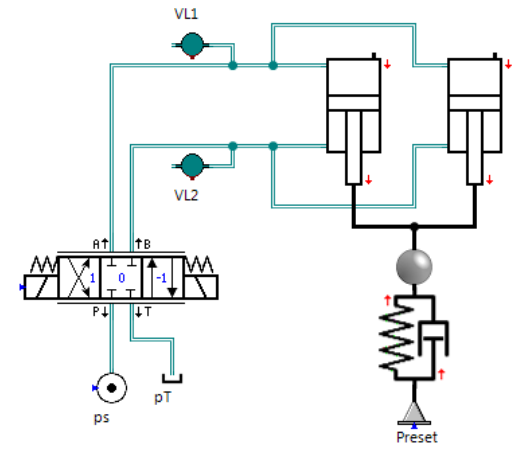
Figure 4: Numerical simulation model constructed us- ing